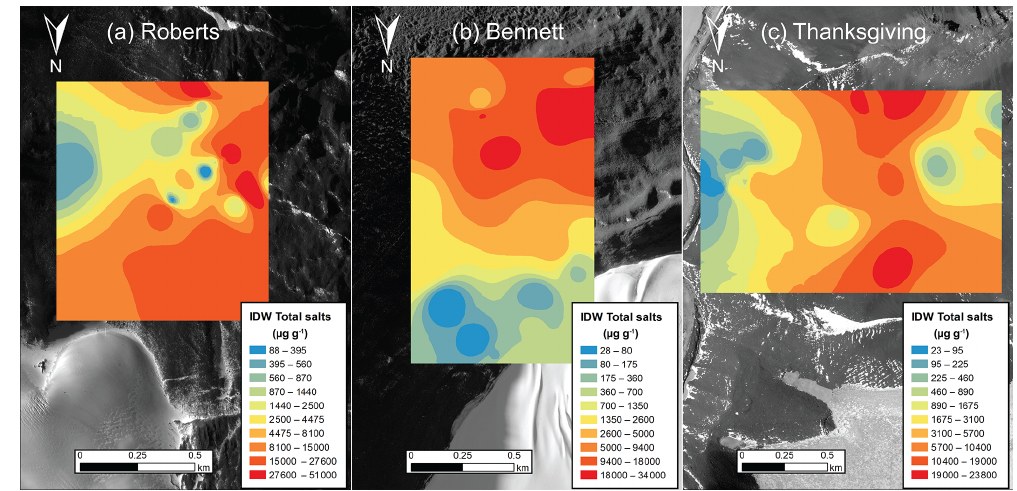
Figure 6. Inverse distance weighted (IDW) interpolations of total salt concentration for Roberts Massif (a) , Bennett Platform (b) , and Thanksgiving Valley (c) . The color scale represents the 10 natural breaks in the data. Interpolations were created and mapped using the Geostatistical Analyst tool in ArcMap